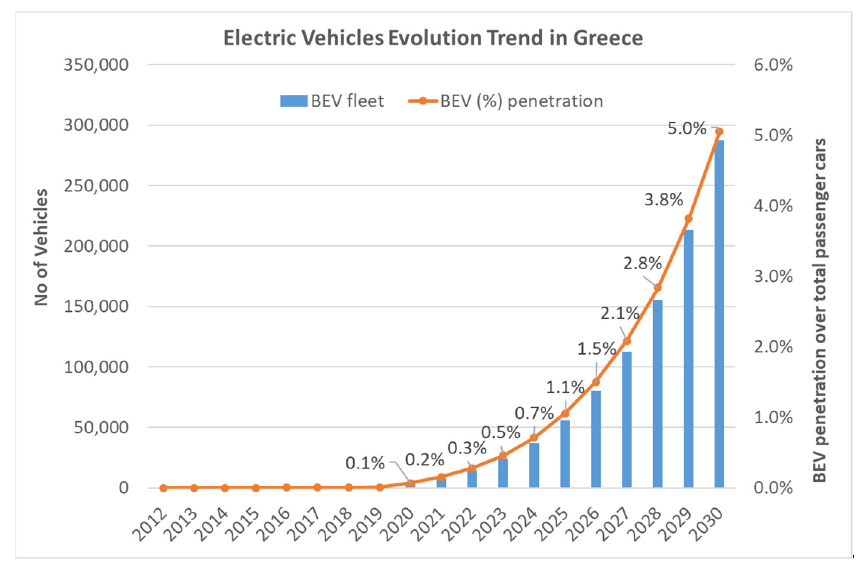
Figure 8. Time-evolution of the fleet size of alternative and electric passenger vehicles in Greece, up to 2030.